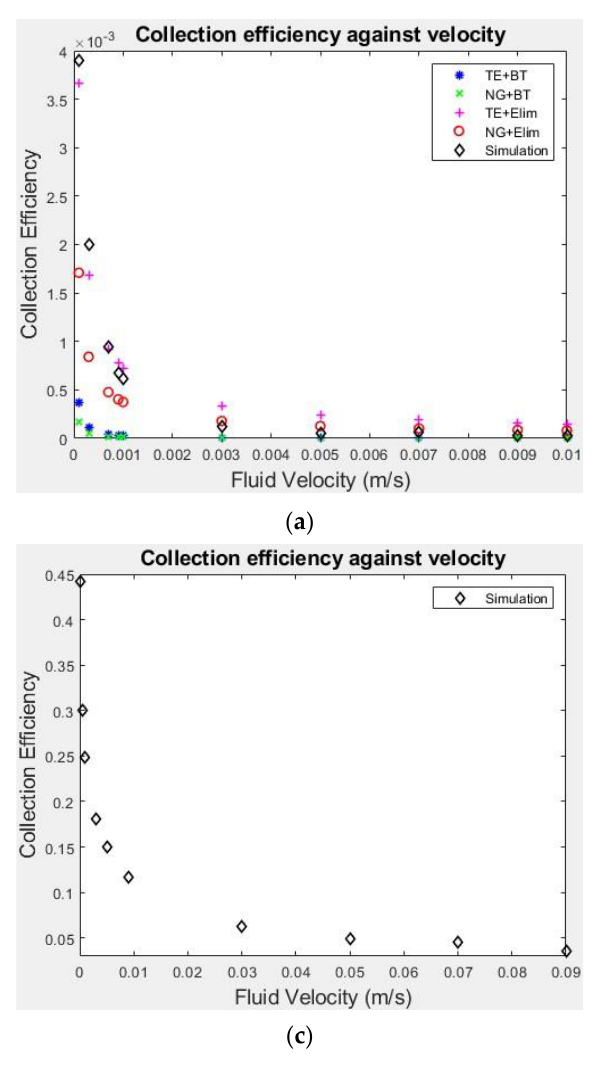
Figure 3. Simulation results for collection efficiency and comparison with results from different correlations: ( a ) for particles with − 30 mV surface charge; ( b ) for particles with zero surface charge; ( c ) for particles with +30 mV surface charge. TE: collection efficiency equation from Tufenji and Elimelich [42] attachment efficiency from Bai and Tien [43], NG: collection efficiency equation from Neslon and Ginn [41], Elim: attachment efficiency from Elimelich (Elim) [40].